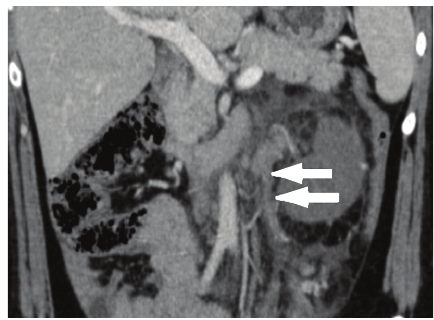
Figure 2: A thrombus including distal part of left ovarian vein